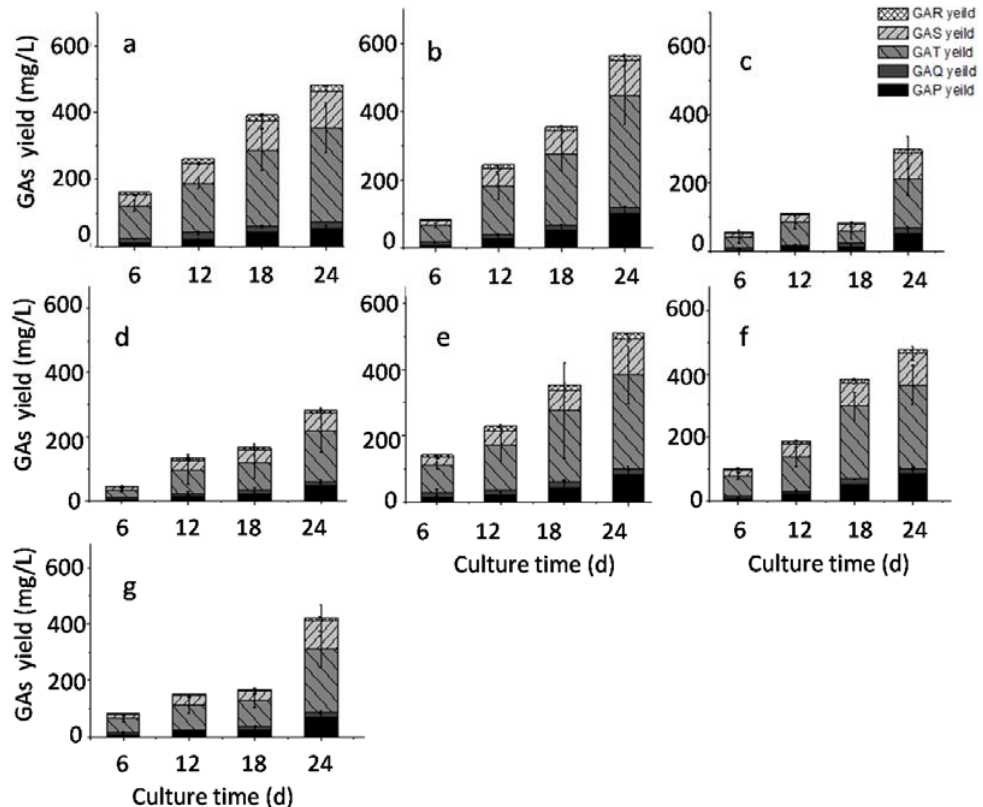
Figure 4. Effects of glucose concentration and supply strategy on the accumulation of five GAs. Notes: ( a ) 30 g/L; ( b ) 40 g/L; ( c ) 50 g/L; ( d ) 60 g/L; ( e ) 30 + 10 g/L; ( f ) 30 + 20 g/L; ( g ) 30 + 30 g/L.